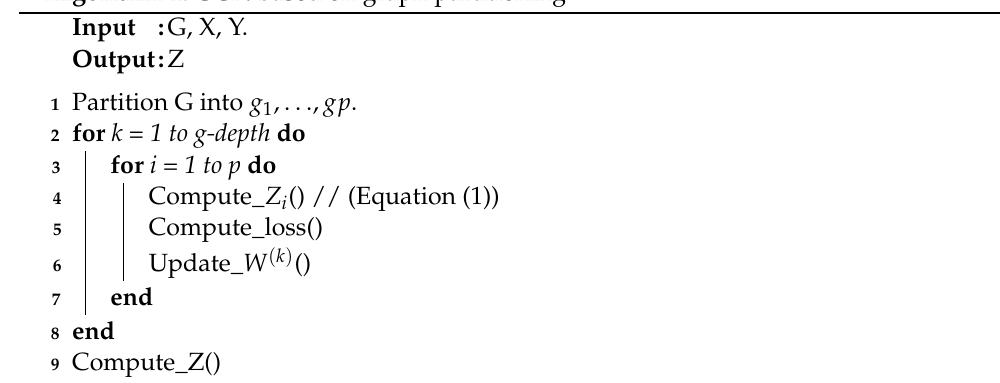
Algorithm 1: GCN based on graph